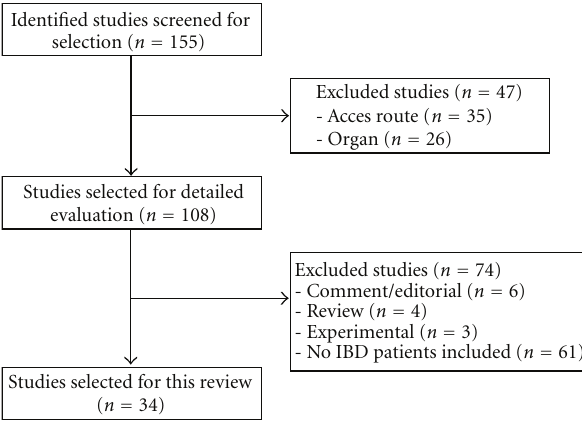
Figure 1: Single-Port Laparoscopic Surgery for inflammatory bowel disease: selection of analyzed